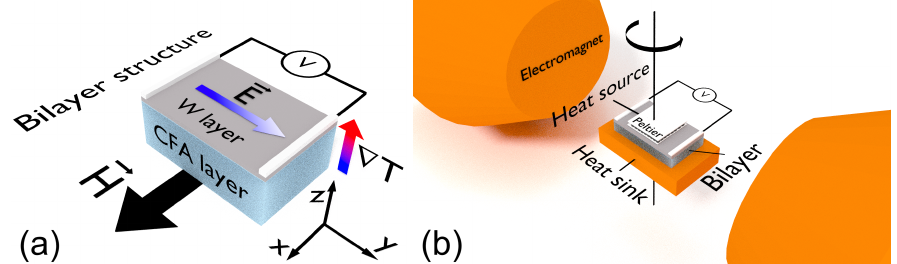
Figure 1. Schematic representation of our bilayer structure and the LSSE experiment. ( a ) Bilayer structure and definition of the coordinate system used in the numerical calculations. Given that ϕ is the angle between the magnetic field and the shortest axis of the sample, ϕ = 0 ◦ is found when (cid:126) H is along the x axis. ( b ) LSSE experimental setup employed for the thermoelectric voltage measurements. The system allowed us the rotation of the sample during the experiment. Notice that the configuration represented in ( b ) corresponds to ϕ = 90 ◦